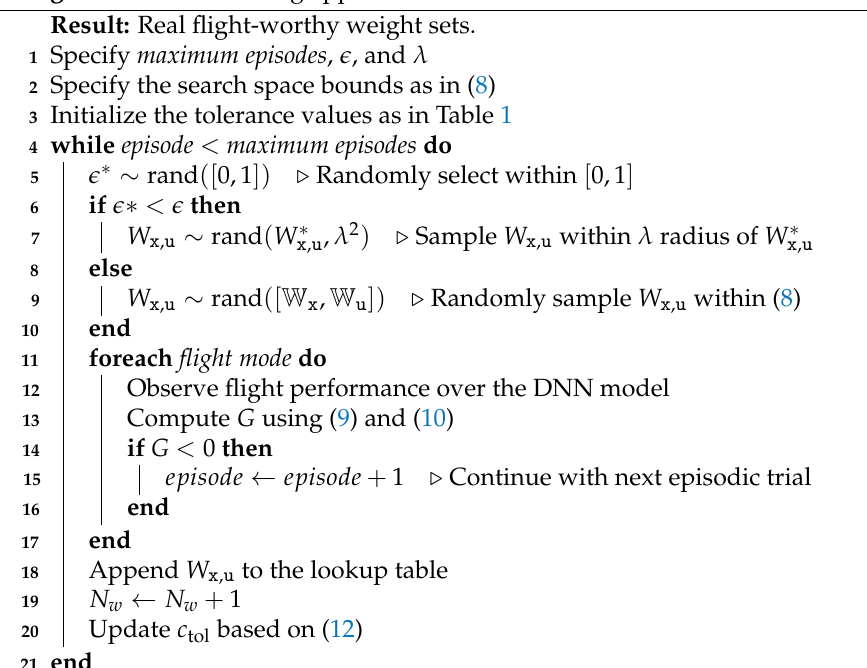
Algorithm 1 Auto-tuning approach